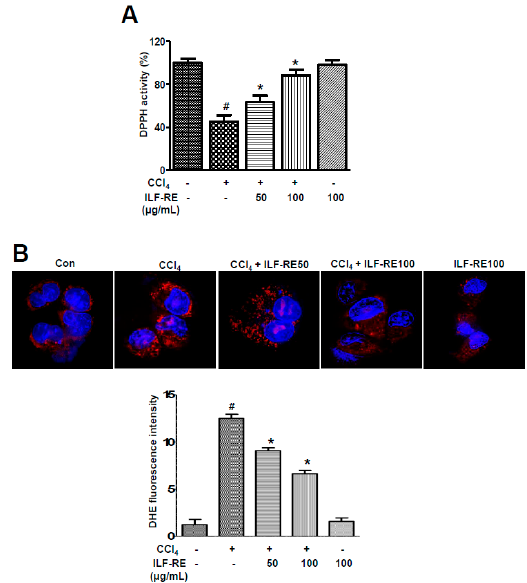
Figure 2. ILF-RE displayed DPPH radical-scavenging activity. Primary hepatocytes were treated with 20 mM CCl 4 in the absence or presence of 50 and 100 µ g/mL ILF-RE for 6 h. ( A ) DPPH radical scavenging was determined in primary hepatocytes. ( B ) Cells were harvested and incubated with 10 µ M of DHE at 37 ◦ C for 30 min, washed with PBS, and assessed using a fluorescence microscope. The scale bar represents 50 µ M. Data are expressed relative to the controls ( n = 3; # p < 0.05 vs. Con; * p < 0.05 vs. CCl 4 ). Con, control; CCl 4 , carbon tetrachloride; ILF-RE, the combination R. verniciflua with E.